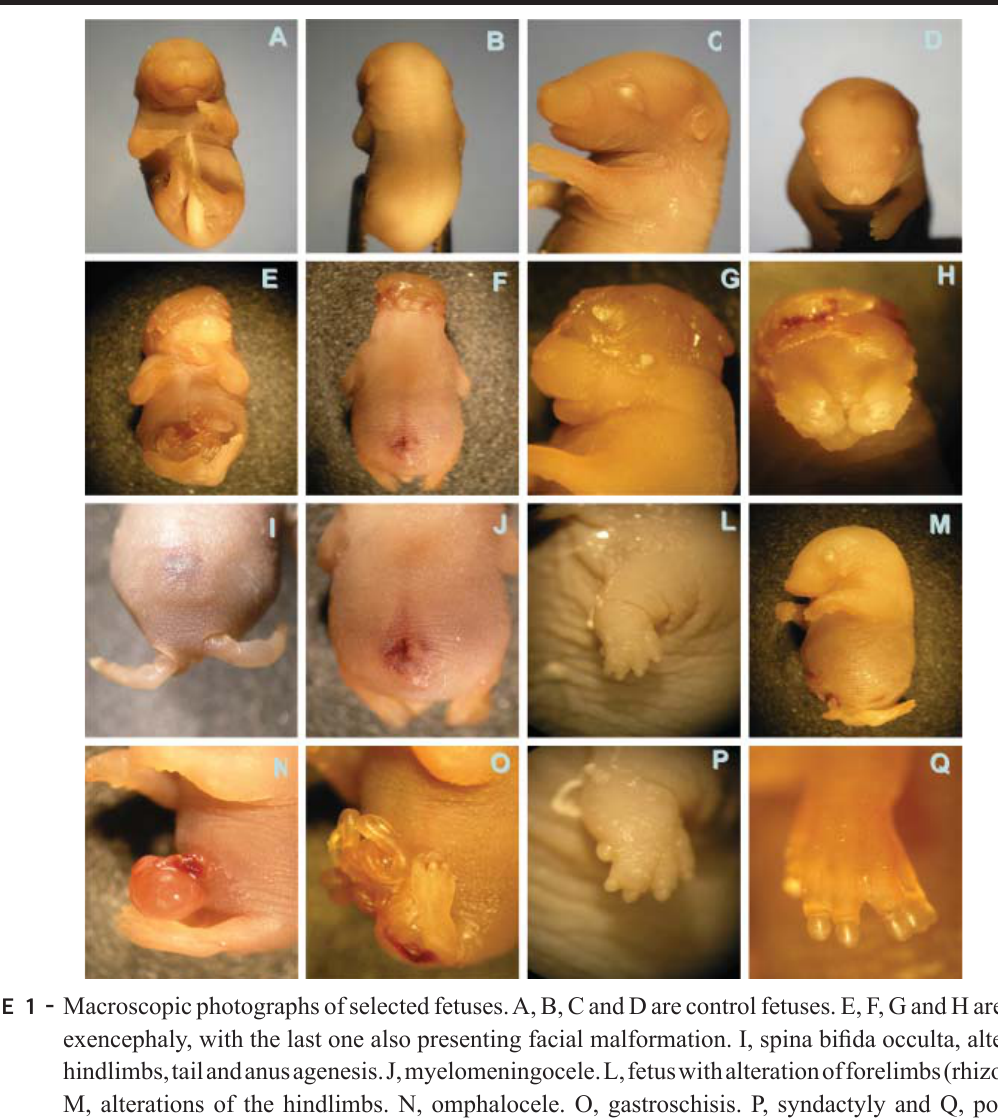
FIGURE 1 - Macroscopic photographs of selected fetuses. A, B, C and D are control fetuses. E, F, G and H are fetuses with exencephaly, with the last one also presenting facial malformation. I, spina bi fi da occulta, alteration of the hindlimbs, tail and anus agenesis. J, myelomeningocele. L, fetus with alteration of forelimbs (rhizomesomelia). M, alterations of the hindlimbs. N, omphalocele. O, gastroschisis. P, syndactyly and Q, polysyndactyly